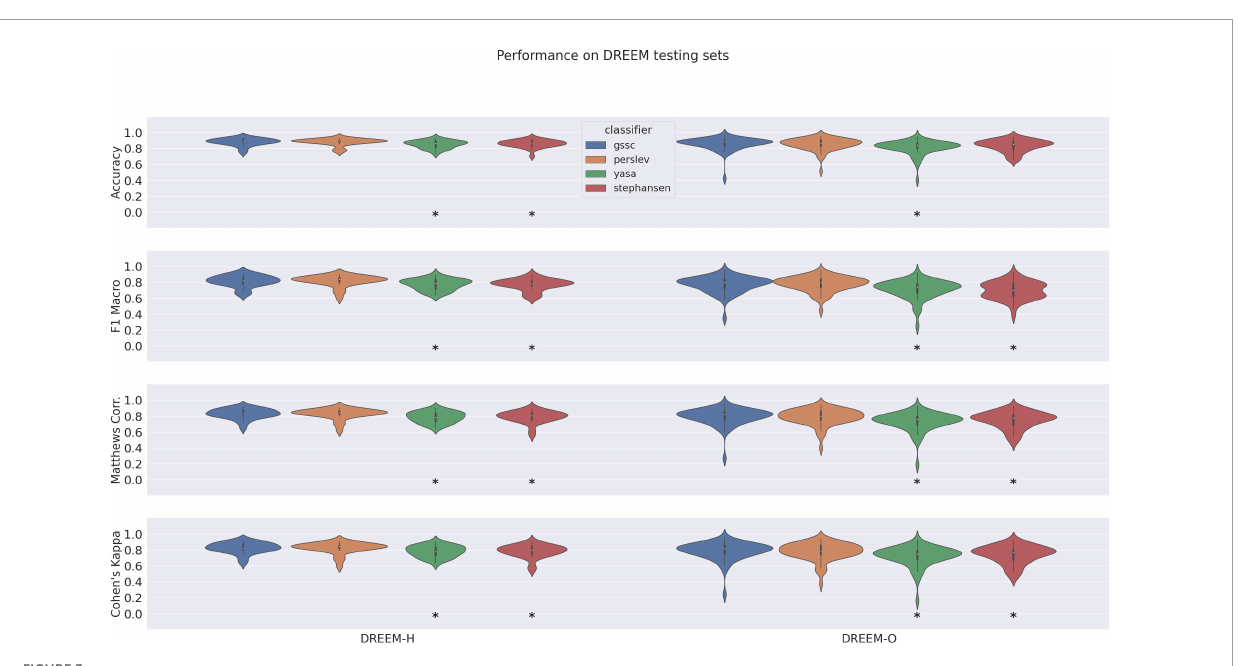
FIGURE3 Violin plots of performance over DREEM dataset for four classifiers. Measures shown here include Accuracy, F1 Macro, Matthews Correlation Coefficient, and Cohen’s Kappa. Asterisks indicate significant differences from GSSC performance, as assessed by a linear mixed effects model with performance as the dependent variable, and classifier as a categorical